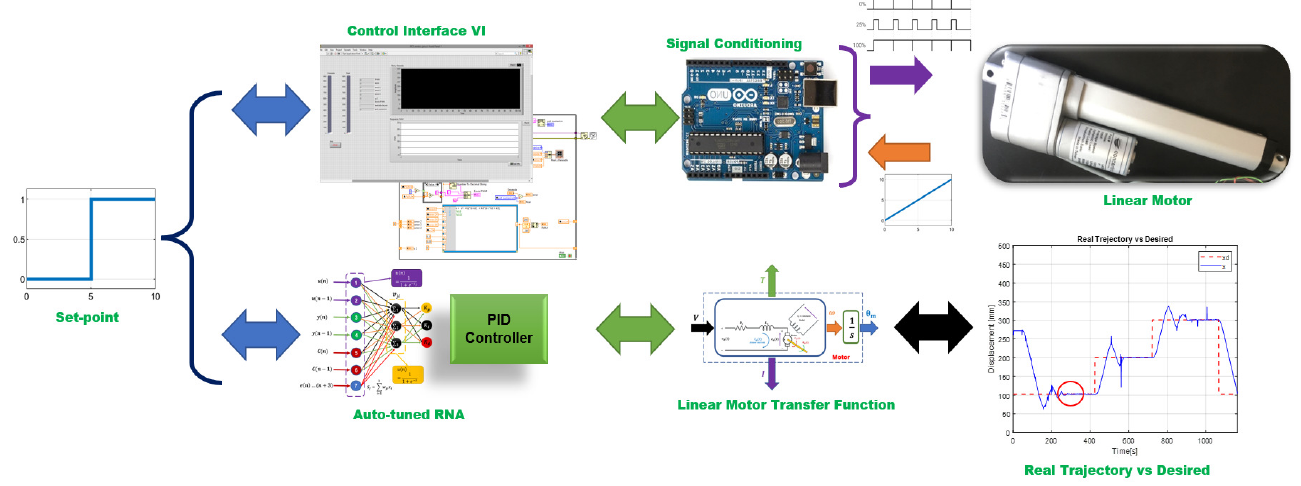
Figure 11. Block diagram for parameter